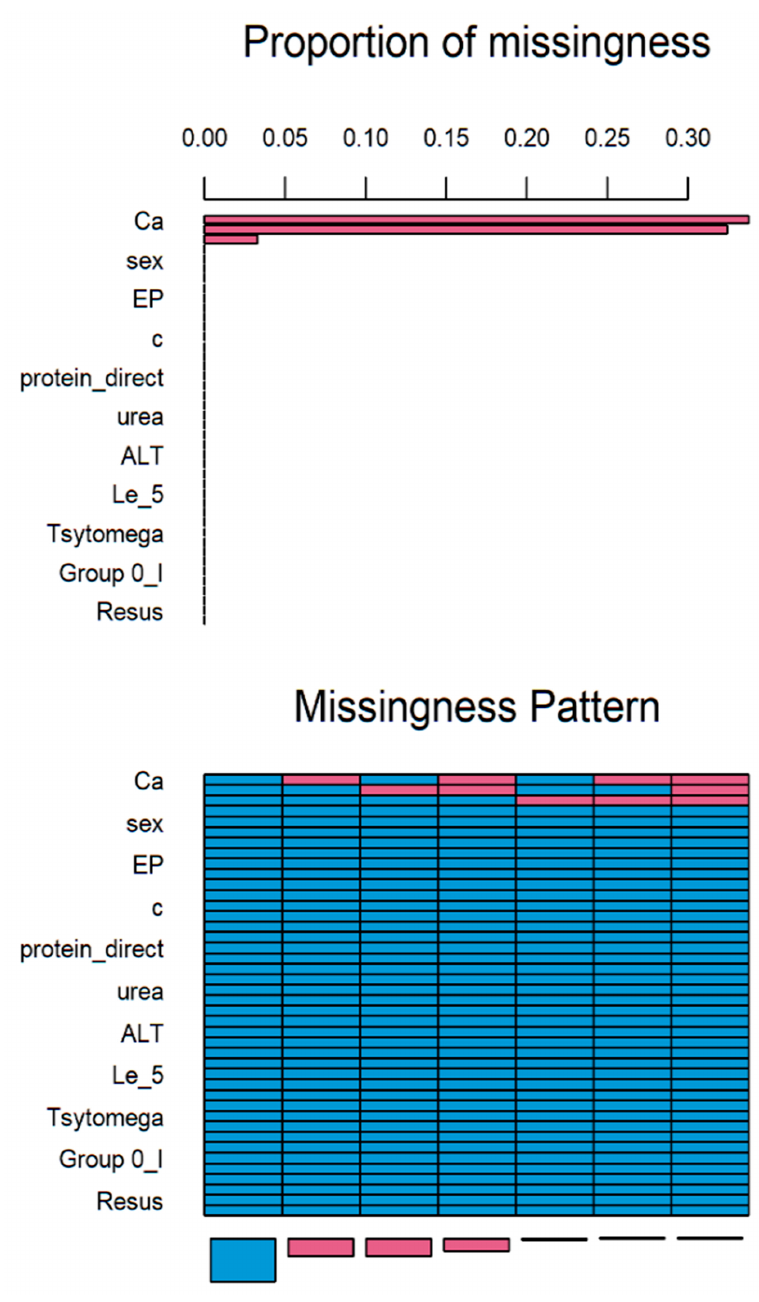
Figure 1. Results of MICE